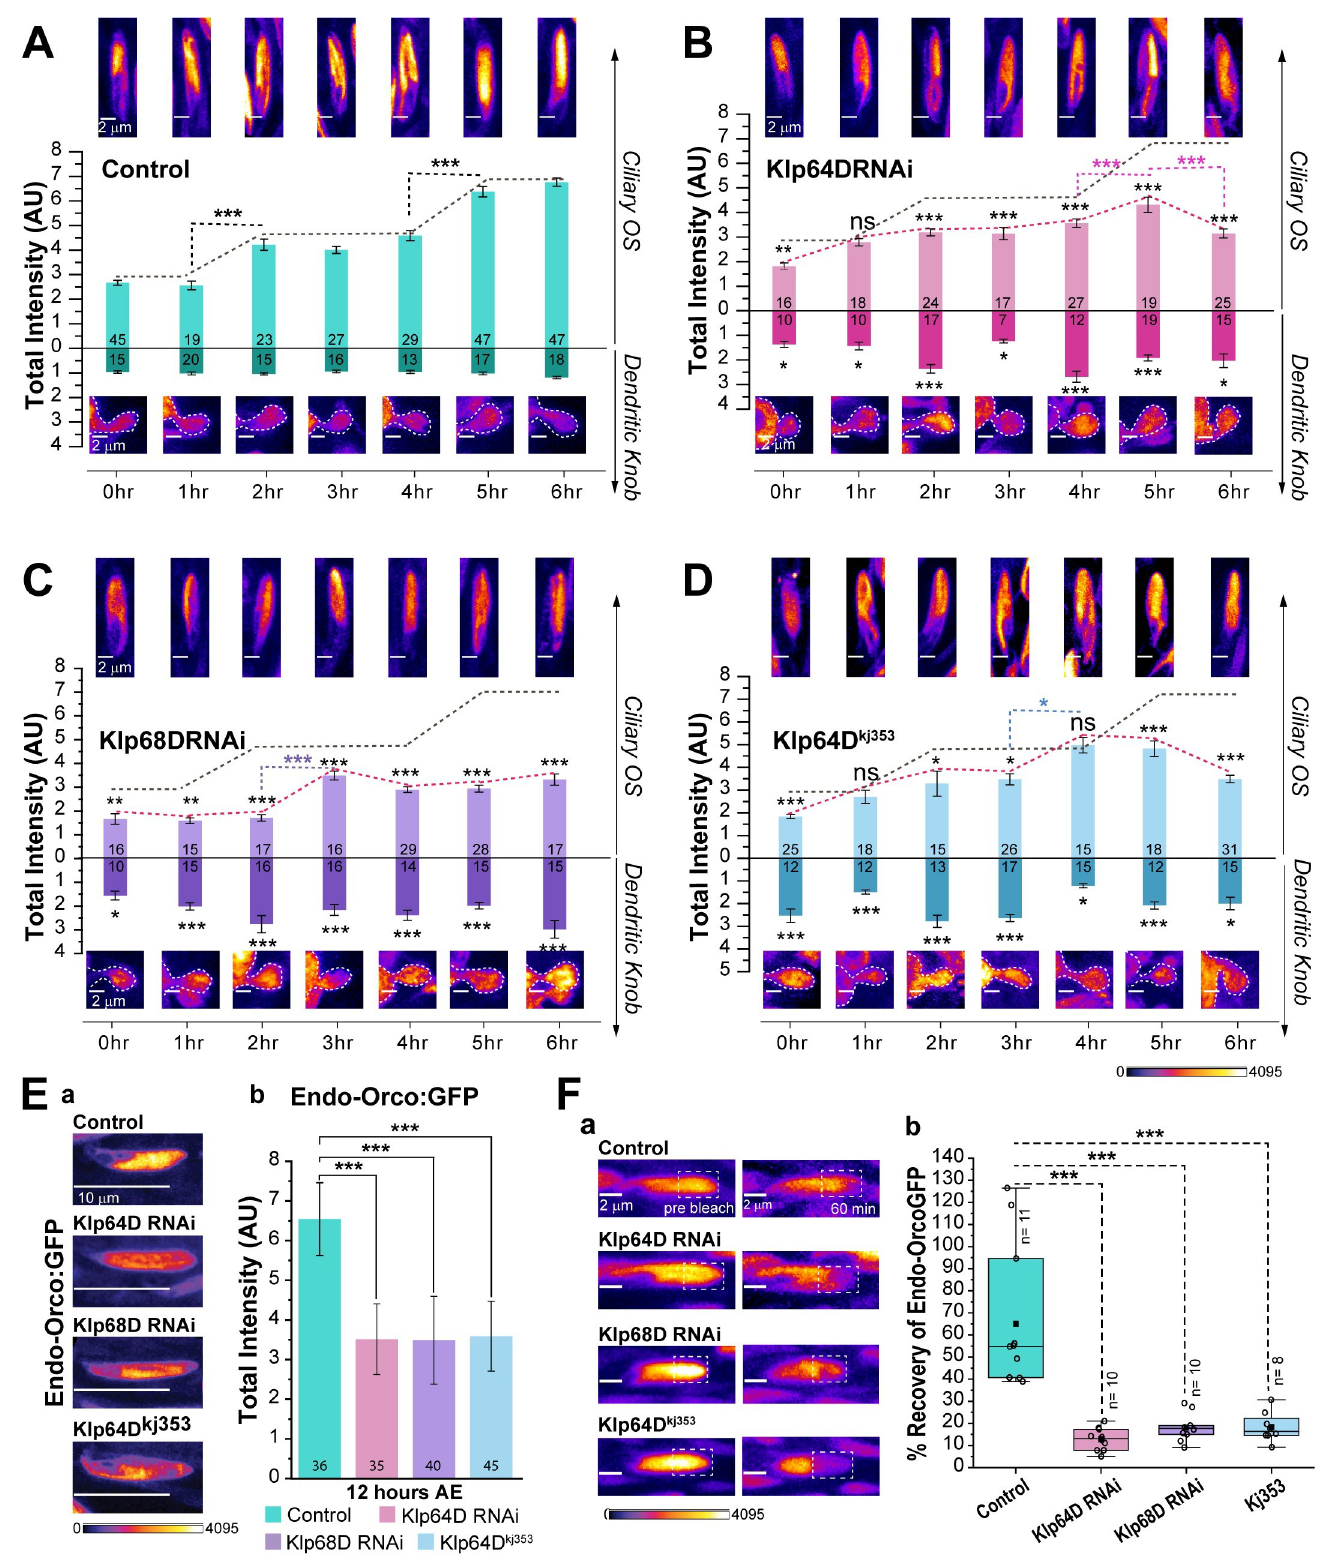
Fig 4. Kinesin-2 is necessary for Orco entry into the olfactory cilia. (A-D) Total fluorescence intensity (mean ± S.E.M) of Endo-Orco:GFP in the ciliary OS and the dendritic knob region of OSNs in Control (A), Klp64D RNAi (B), Klp68D RNAi (C) and homozygous Klp64D kj353 mutant (D) backgrounds, respectively. The pairwise significance of difference as compared to the wild type control and between different stages was estimated using one-way ANOVA test, and the p-values